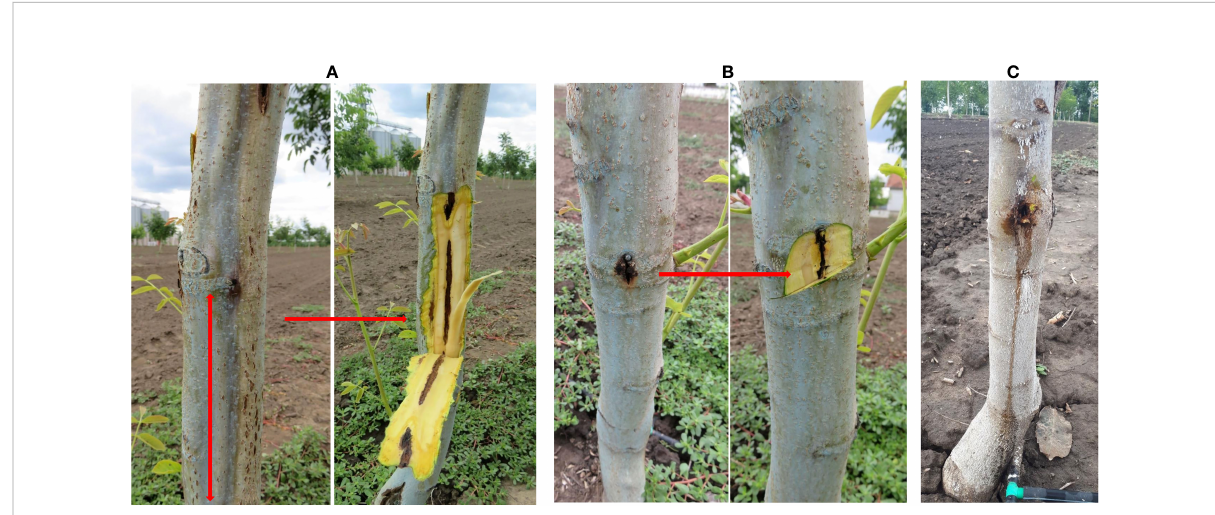
FIGURE 1 Symptoms of deep bark canker on walnut, before and after bark removal. (A) Dark brown to black, sunken longitudinal lesions under the bark of walnut; (B) Extensive discoloration of the tissue that extend deeper into the xylem; (C) Longitudinal oozing cracks. Natural